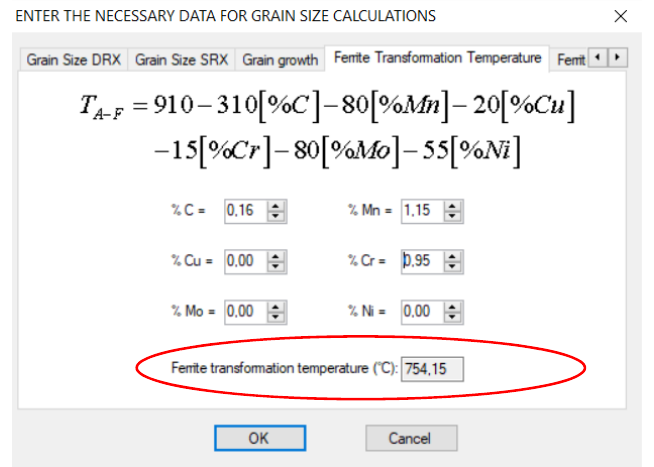
Figure 18. Ferrite transformation temperature used in the simulations based on the chemical composition of the steel.